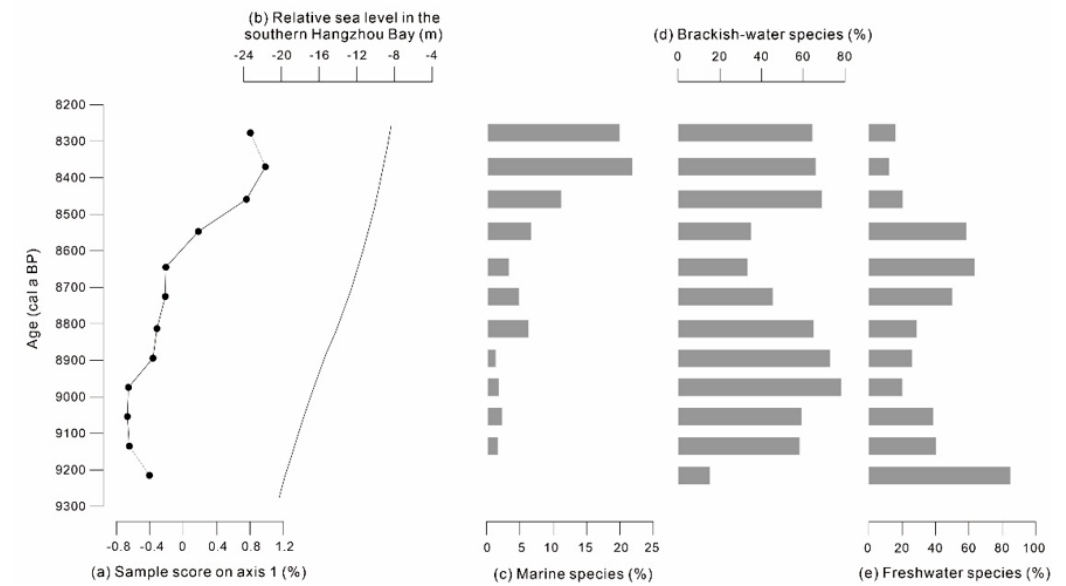
Figure 4. ( a ) Sample score on axis 1, ( b ) relative sea level in the southern Hangzhou Bay [36]